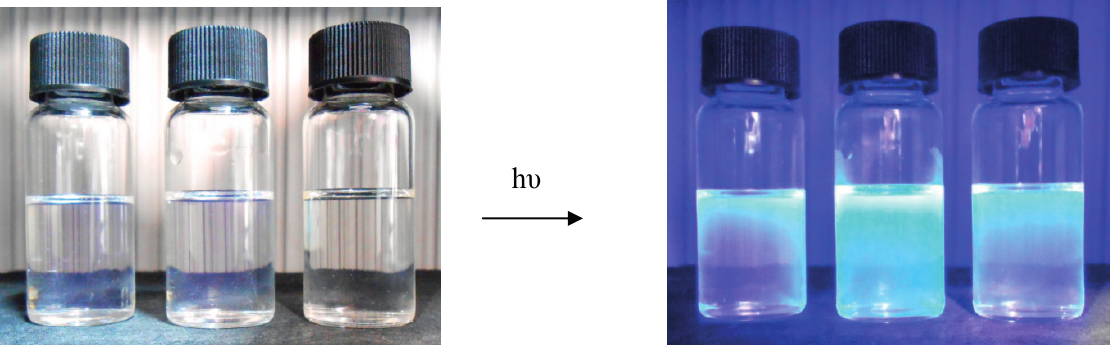
Cl , CH OH and CH 2 2 3